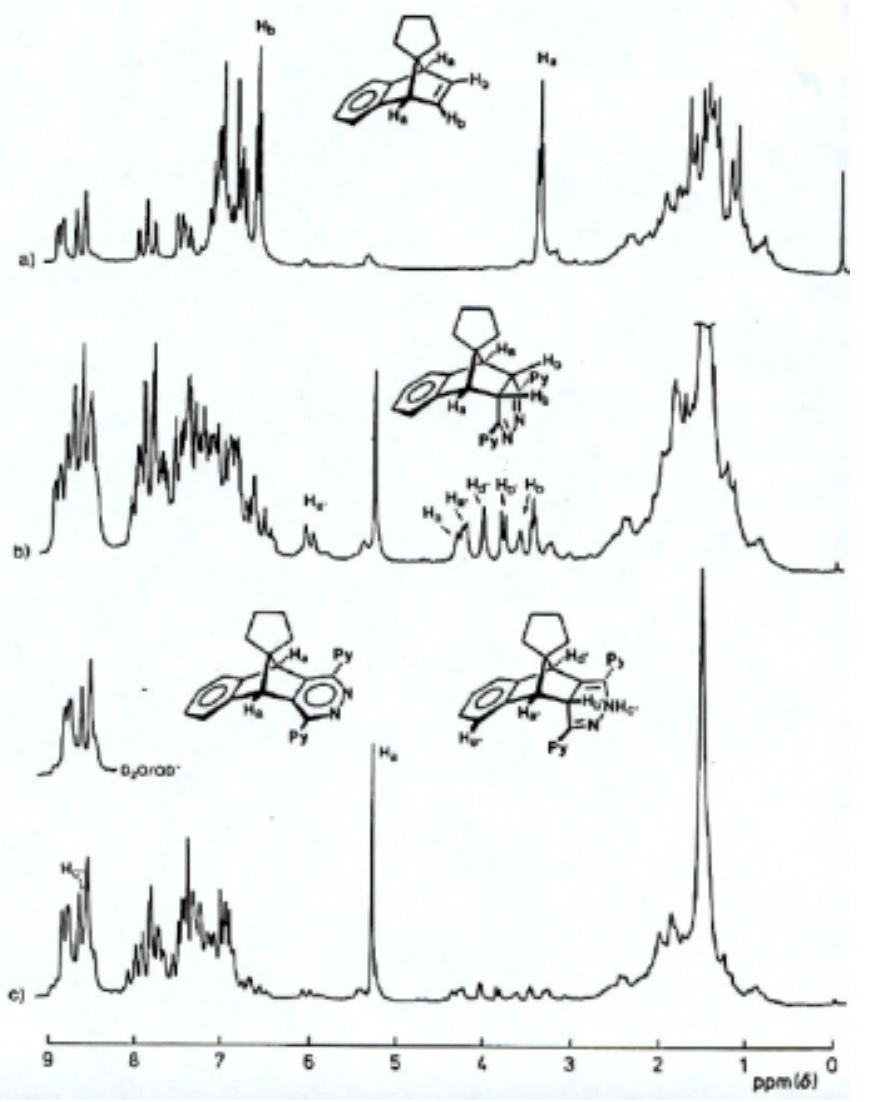
Figure 7. 1 H-NMR